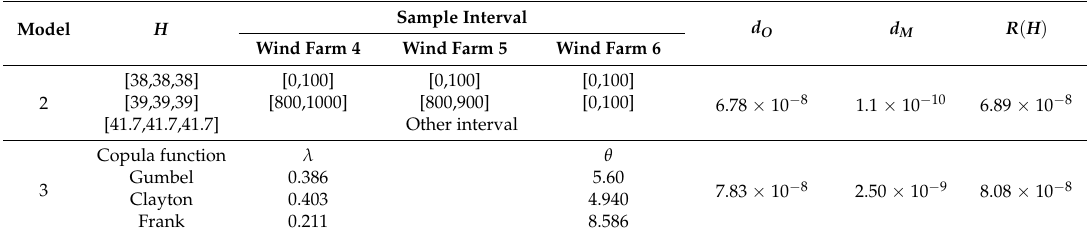
Table 4. Comparison of Applicability between AMNKDE and Copula Parameter